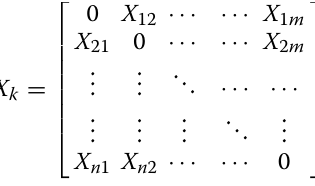
Step 1: Linguistic evaluations were conducted by an expert team. Table two was used to collect the evaluations from